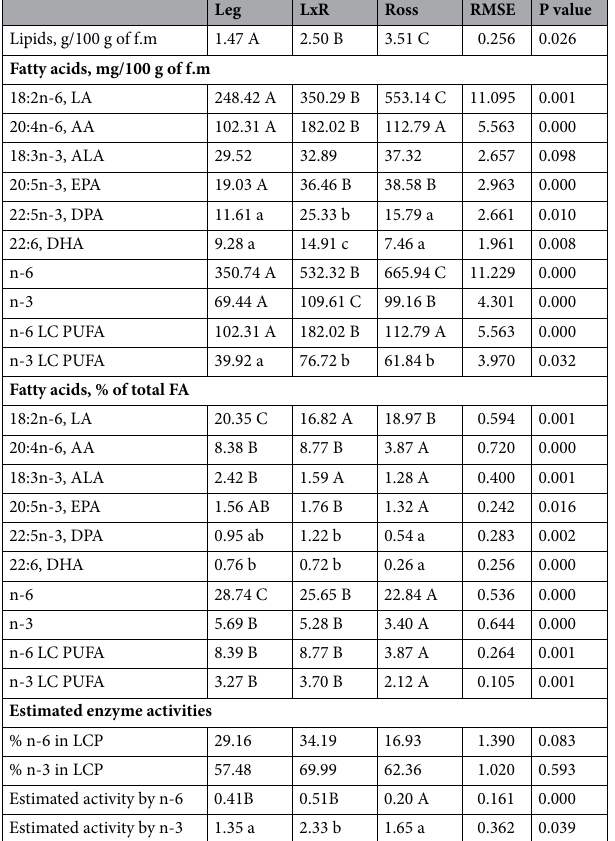
Table 1. Total lipid content (g/100 g of fresh matter), n-3 and n-6 PUFA of breast muscle expressed as mg/100 g of fresh matter and % of total FA and estimated lipid enzyme activities. A, B on the same row differ for P < 0.001 (post hoc Tukey’s test). a, b on the same row differ for P < 0.01 (post hoc Tukey’s